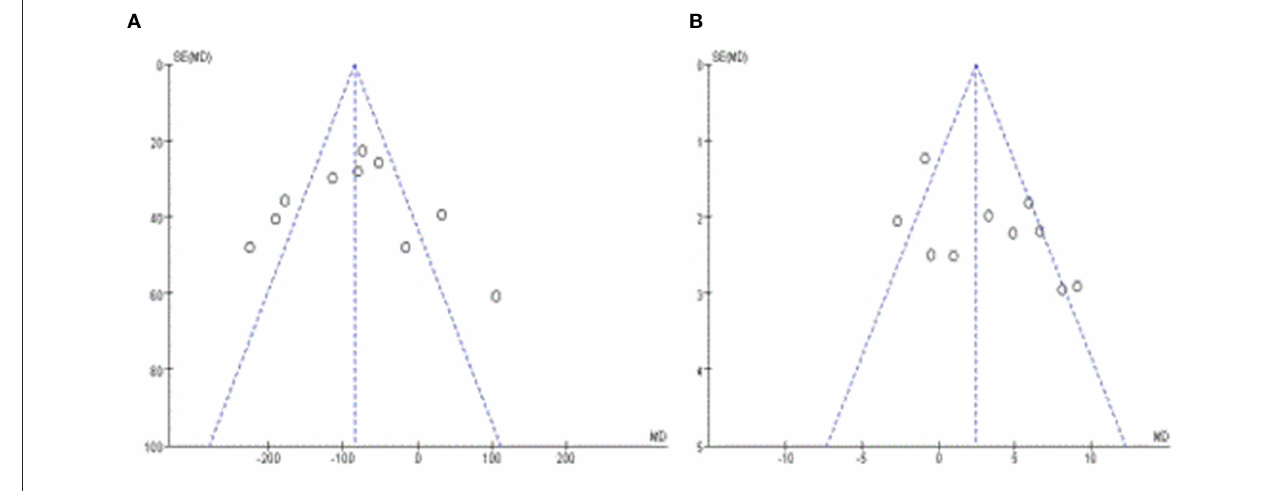
FIGURE 2 | (A) Funnel plots of PLT. (B) Funnel plots of